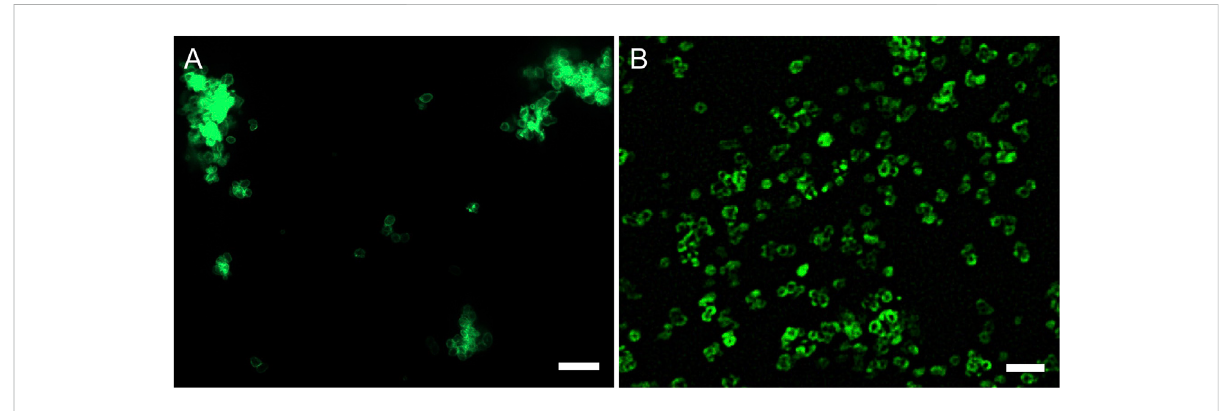
FIGURE 4 Micrographs of (A) FITC-labeled PAH coated at 3rd bilayer of CaCuMg-PEM-Col and (B) FITC-labeled collagen coated at the outmost layer (scale bar = 50 μ